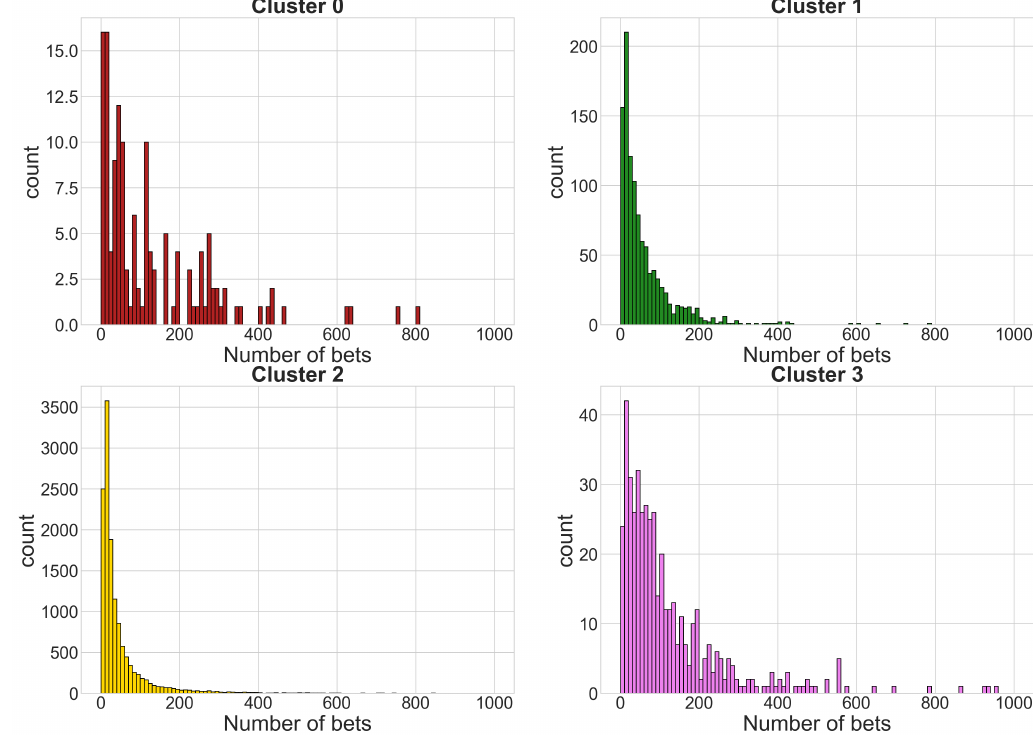
Figure 3. Histograms of the number of bets obtained using the time series k -means algorithm. The x axis reports the number of bets, while the y axis shows the number of players that have performed that number of bets during the month.